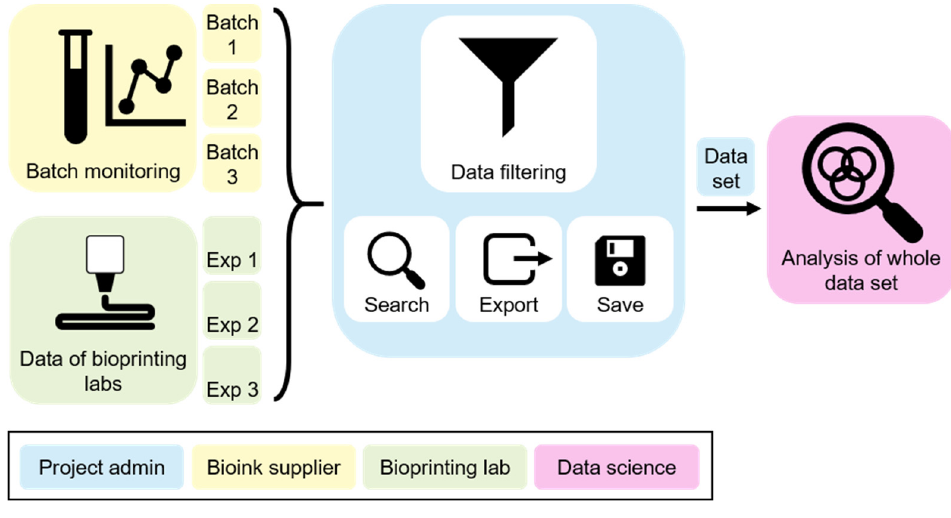
Figure 4. Visualisation of the workflow centred around the developed Python tool. An arbitrary number of records organised in a collection from bioink suppliers (raw material batch analysis data) and bioprinting labs (bioink preparation and bioprinting protocols) is edited with the Python script by the project admin with the aim of filtering out certain data. A new (anonymised) collection is created and transferred to analysis.